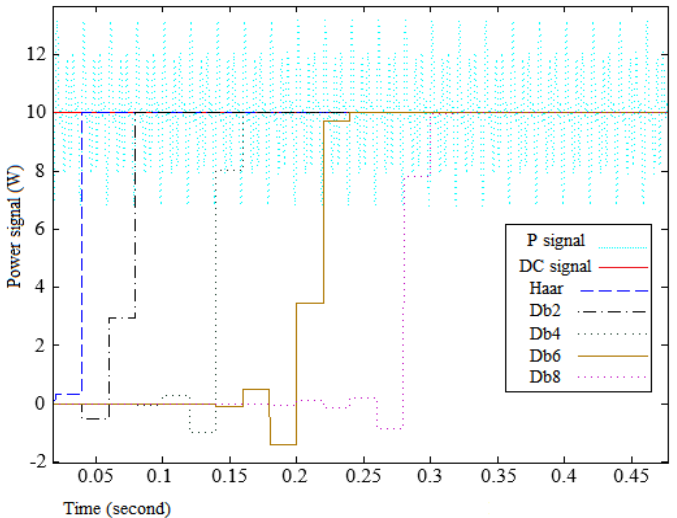
Figure 7. The extracted DC signals using a wavelet-based low-pass filter controlled by different mother wavelets.